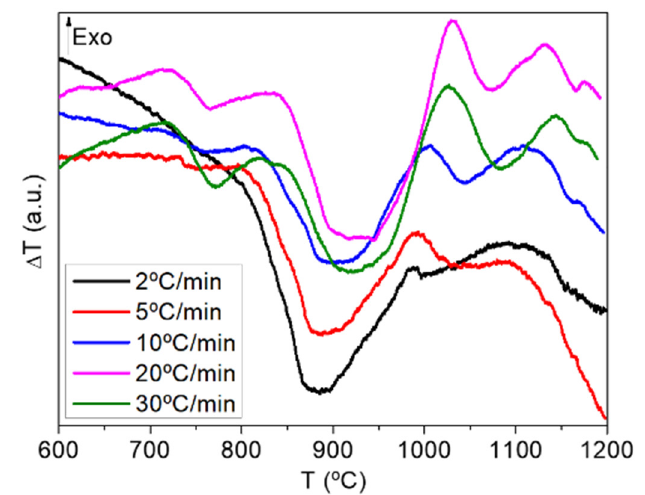
Figure 1. DTA curves of the undoped glass with different heating rates (ø < 20 μ m). Table 2. T g , T x , and T c of the undoped glass (ø < 20 μ m) determined by DTA.